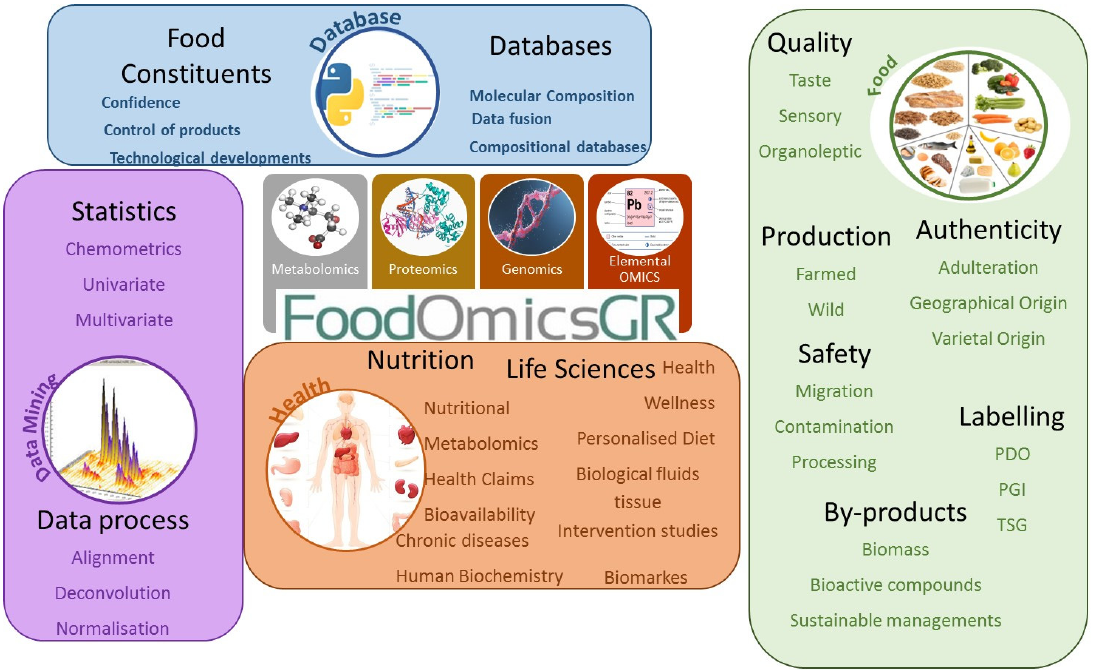
Figure 1. Schematic illustration of the major technologies of the FoodOmicsGR_RI in the center, where the data are generated (metabolomics, genomics, proteomics, elemental metabolomics), and the different action points and work-packages on the periphery where the data are further treated by statistics and then organized in databases. At the right, the application in Food characterization toward authenticity, quality evaluation safety and waste re-use. At the bottom, the studies that aim to highlight the nutritional value of Greek foods. In black/bold, the priority areas; in coloured fonts, areas with potential for synergy and development.